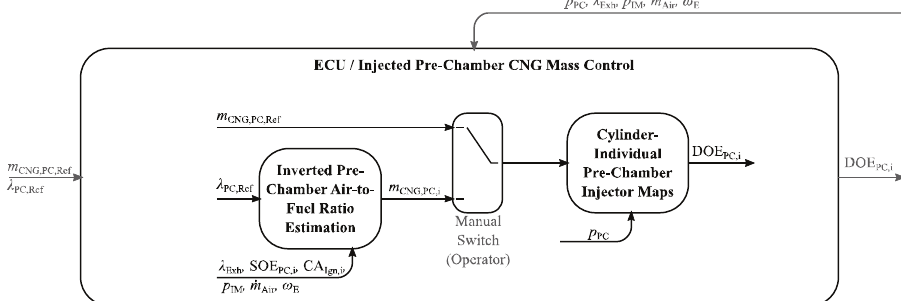
Fig. 7. Implemented feed forward functionalities for the pre-chamber scavenging. The operator can either set the desired air-to-fuel ratio inside of the pre- chambers at the time of ignition, or he can set the CNG mass to be injected